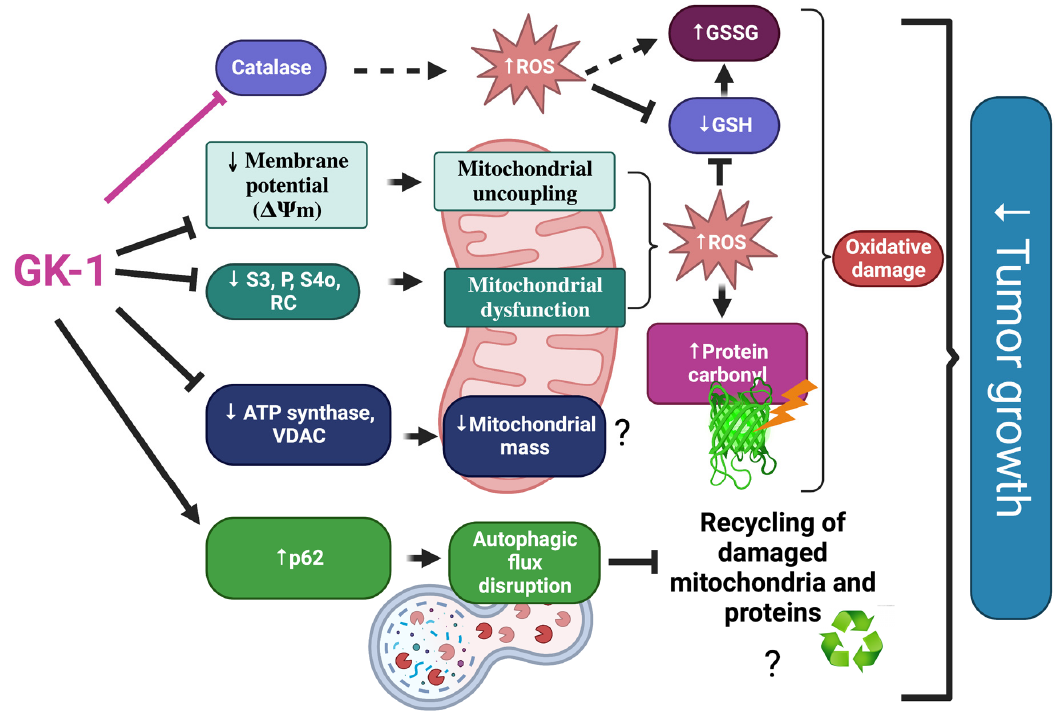
Figure 10. Integrative schema. GK-1 decreases catalase activity and mitochondrial respiration evaluated by state 3 (S3), oxidative phosphorylation-linked respiration (P), state 4 induced by oligomycin (S4o) and respiratory control (RC) and mitochondrial membrane potential ( ΔΨ m) inducing mitochon- drial dysfunction and mitochondrial uncoupling. These alterations could induce reactive oxygen species (ROS) overproduction, oxidative stress, and oxidative damage (protein carbonyl formation, decrease in glutathione (GSH) levels and increase in glutathione disulfide (GSSG) levels). More- over, GK-1 decreases adenosine triphosphate (ATP) synthase and voltage-dependent anion channel 1 (VDAC1) levels affecting mitochondrial mass and decreases Beclin and increases p62 that are associated with disruption of autophagic flow, reducing triple-negative breast tumor growth. The figure was created with